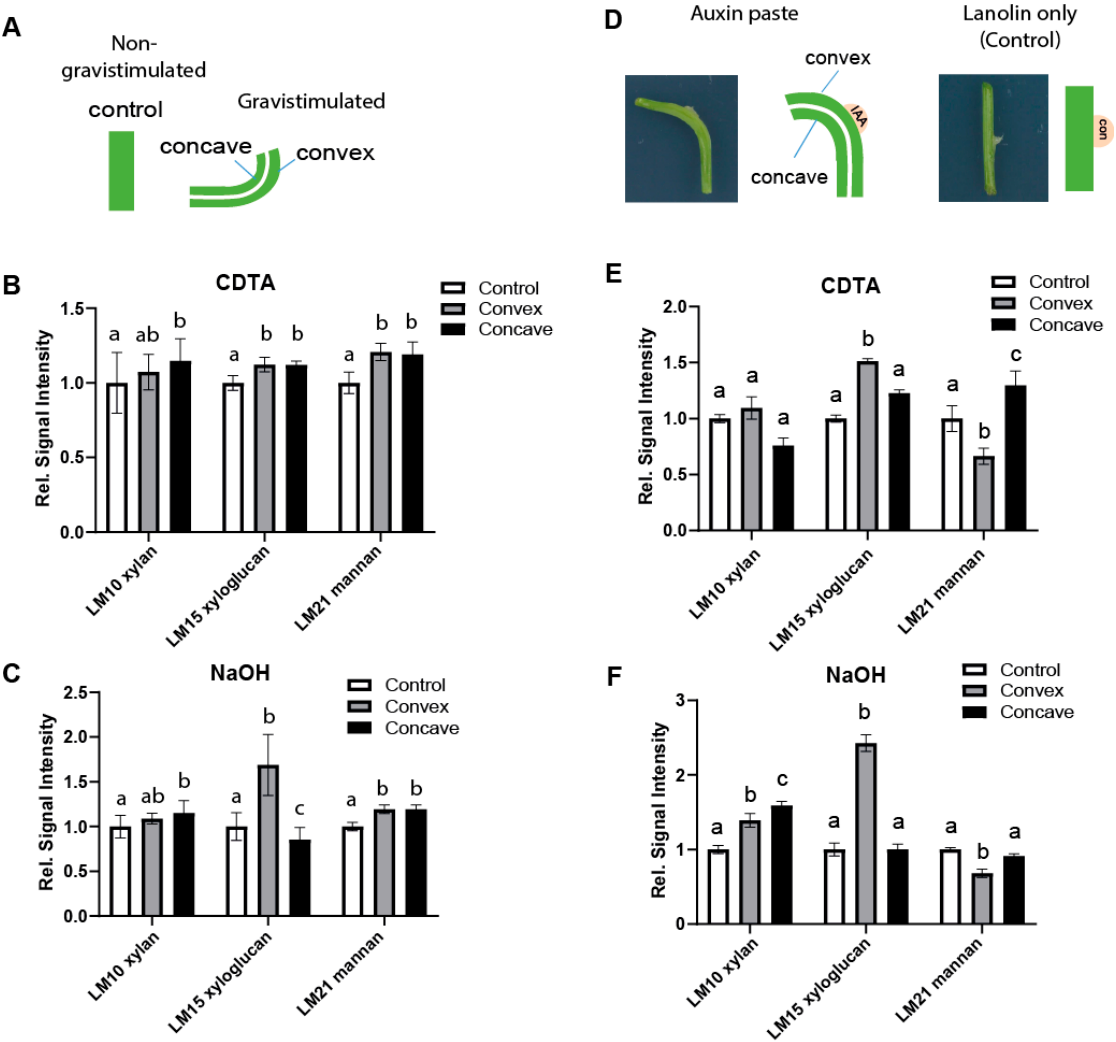
Figure 1. ( A – C ) Comprehensive Microarray Polymer Profiling (CoMPP) of differentially elongated stem segments after gravistimulation. The LM15 antibody, specific to the non-galactosylated (XXXG) motif of Xyloglucan (XyG), showed increased epitope detection in longer stem segments. ( A ) Schematic of the experimental design. ( B , C ) Quantification of relative changes in the signal intensities with a cyclohexanediaminetetraacetic acid (CDTA) ( B ) and NaOH ( C ) extraction in relation to non-stimulated control (n = 10 sectioned pairs, error bars represent SEM). Two-way ANOVA followed by Tukey’s test with p -value <0.05. ( D – F ) CoMPP profiling of pea segments after three-day treatment with an indole-3-acetic acid (IAA)-containing lanolin paste. ( D ) Schematic representation of the auxin application assay. ( E , F ) Relative quantifications of both CTDA ( E ) and NaOH ( F ) extractions, in comparison to the non-treated control (n = 7 independent curvature sections, error bars represent SEM). Two-way ANOVA followed by Tukey’s test. Similar letters in the graphs mark no significant statistical difference. Different letters in the graphs mark significant statistical difference with a p -value < 0.05.